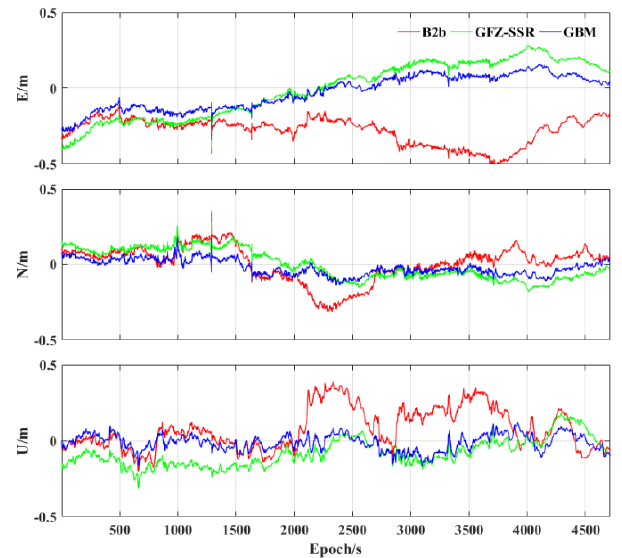
Figure 7. Positioning error of the three precise products using tactical IMU. Table 4. RMS statistics of positioning error for the three precise products using tactical IMU (unit: